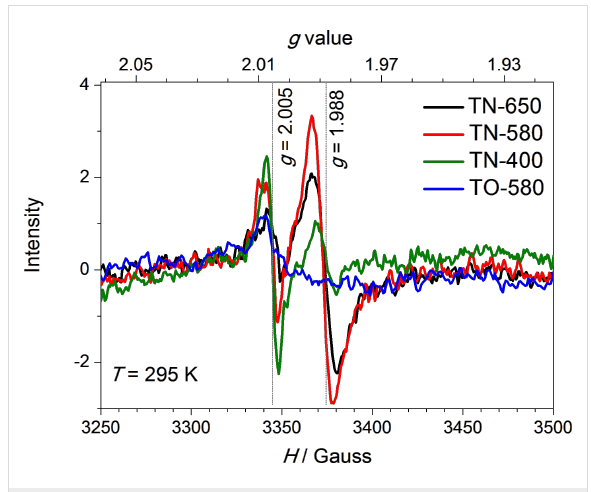
Figure 8: Room-temperature EPR spectra of TiO 2 nanoribbons derived from hydrogen titanate nanoribbons by calcination in an NH 3 (g)/Ar(g) flow ( TN-650 , TN-580 and TN-400 ) and air ( TO-580